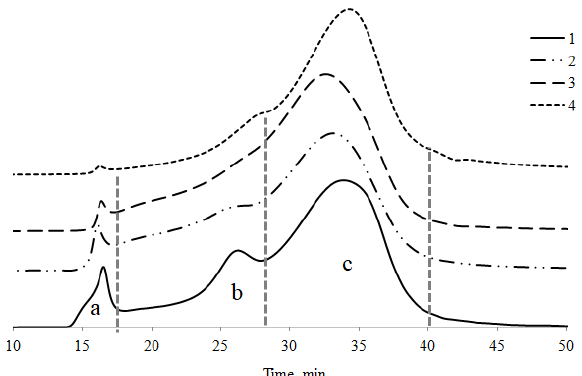
Figure 5. Typical gel chromatograms: 1—HAs from Eutric Albic Stagnic Histic Retisol (Loamic) (hor. Ehg, internal standard); 2, 3, 4—HAs from Plot 2-1 (hor. Hi 0–10 cm, hor. Hi2 30–33 cm, hor. Hif8 250–265 cm corresponding).